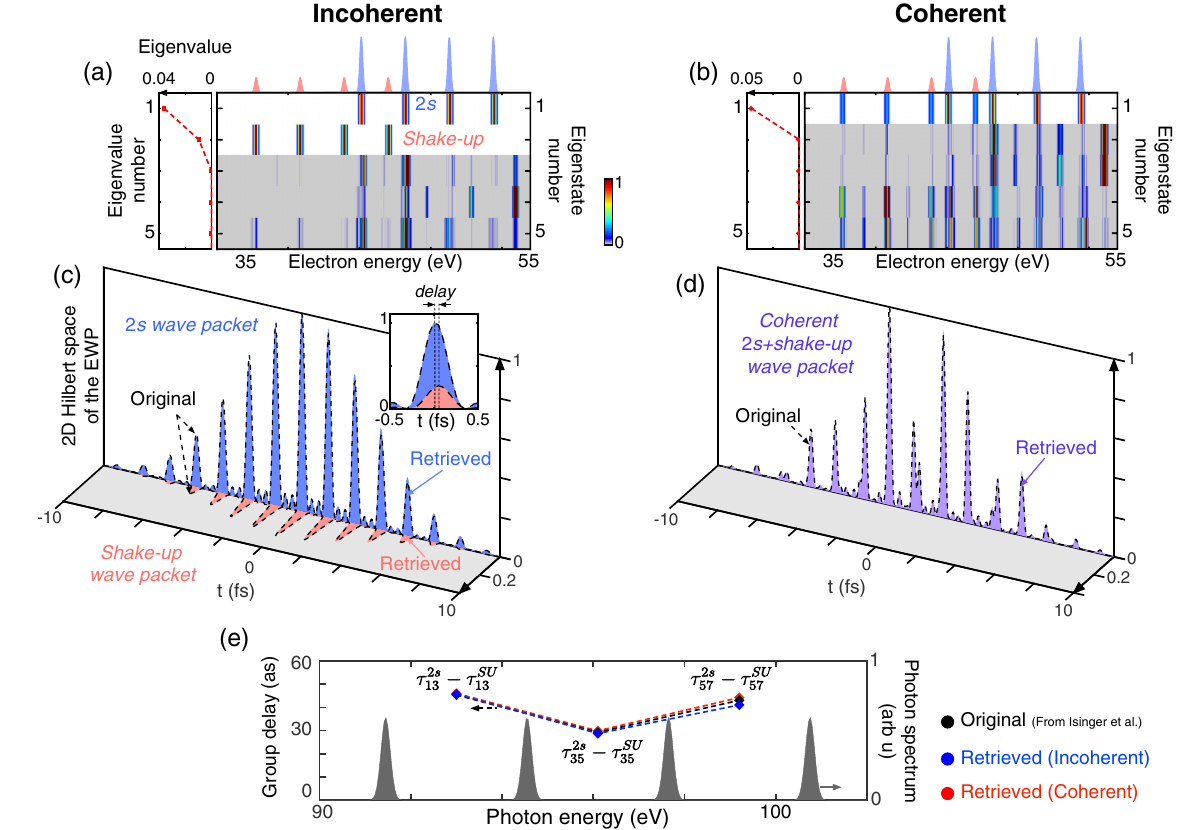
FIG. 6. Eigenstate decomposition of the multichannel density matrix in the coherent and incoherent cases. (a),(b) Eigenvalues λ i of ρ ð ϵ ; ϵ 0 Þ sorted in decreasing order (left) and modulus of the associated eigenstates j χ ϵ Þj (right). When λ i ð i is negligible, the eigenstate is shaded in gray. (c),(d) After Fourier transforming the dominant eigenstates, one obtains the time-domain wave packets j χ i ð t Þj 2 (shaded curves); the black dashed lines show the time profile of the exact wave packets used to perform the simulation. (e) The photoionization time delays can easily be recovered from the retrieved density matrices (dots connected by dashed lines); see the main text for details. The original delays are taken from Ref. [19]. The high-harmonic photon spectrum is also shown (gray shaded